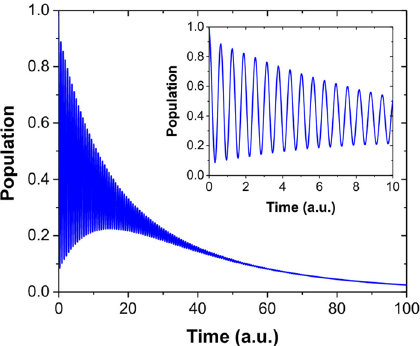
Figure 1. Pictorial representation of a damped Rabi oscillation in a two-level system. Inset: Enlarged view of the short time behavior of the relaxation.